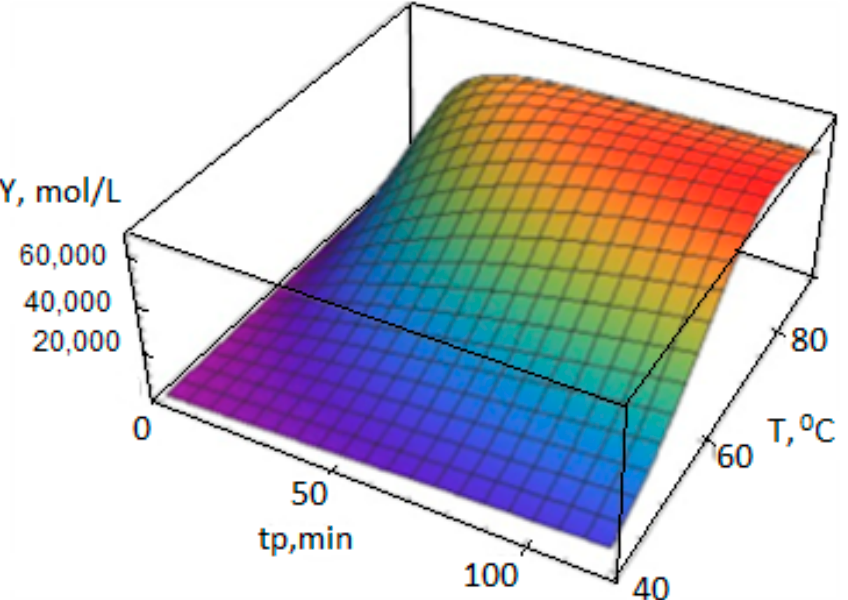
Figure 3. Dependence of the output of PP Y p , g PP /g cat , on the temperature T and the polymerization duration t p , calculated according to the polycenter model using the growth, activation, and deactivation energies from Table 3 (polymerization conditions in Table 1).